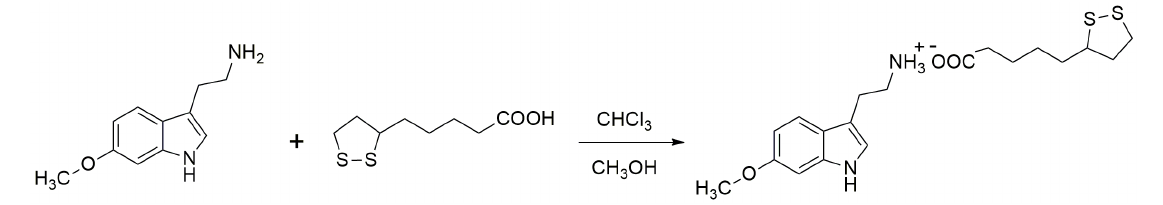
Figure 1. Synthesis and structure of 5-methoxytryptamine- α -lipoic acid (MLA).